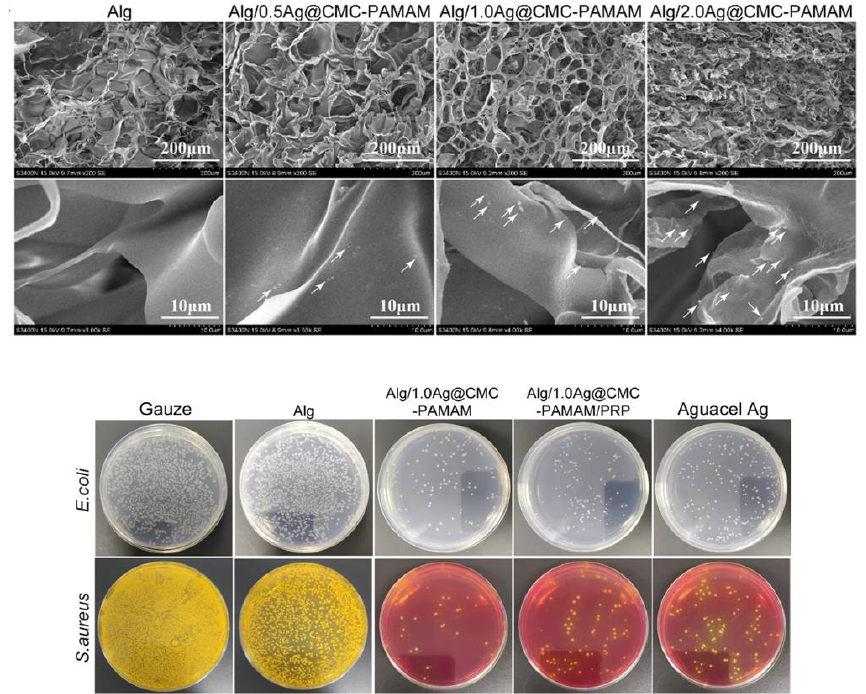
Figure 7. ( Top ) SEM images of the lyophilized Alg (pure alginate hydrogel), Alg/0.5Ag@CMC– PAMAM (alginate hydrogel with silver–carboxymethyl chitosan–polyamideamine composite nanoparticles), Alg/1.0Ag@CMC–PAMAM, and Alg/2.0Ag@CMC–PAMAM dressing. The white arrows point to the nanoparticles adhering to the dressing matrix. ( Bottom ) Bacterial colonies’ formation of E. coli and S. aureus from rat wounds after 3 days. Adapted and reprinted with permission from [133].